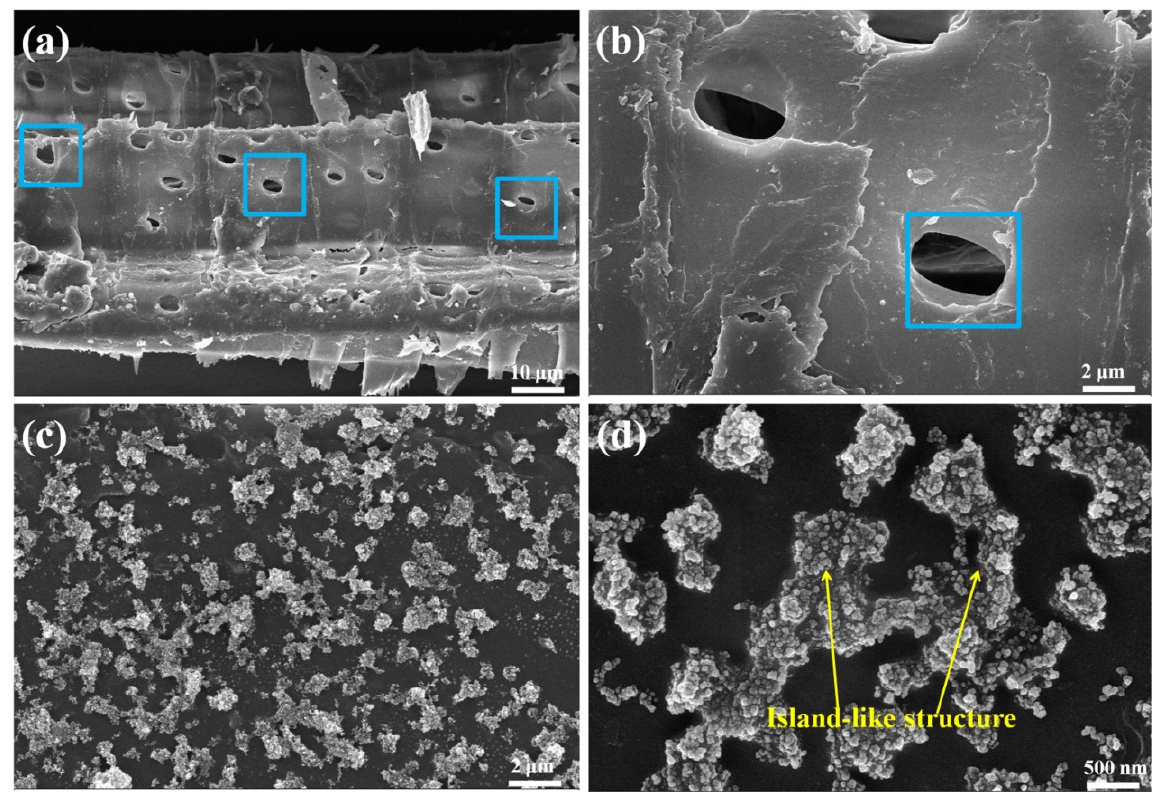
Figure 4. SEM images of original wood surface ( a , b ) and superhydrophobic silicone resin coatings on the treated wood surface ( c , d ).